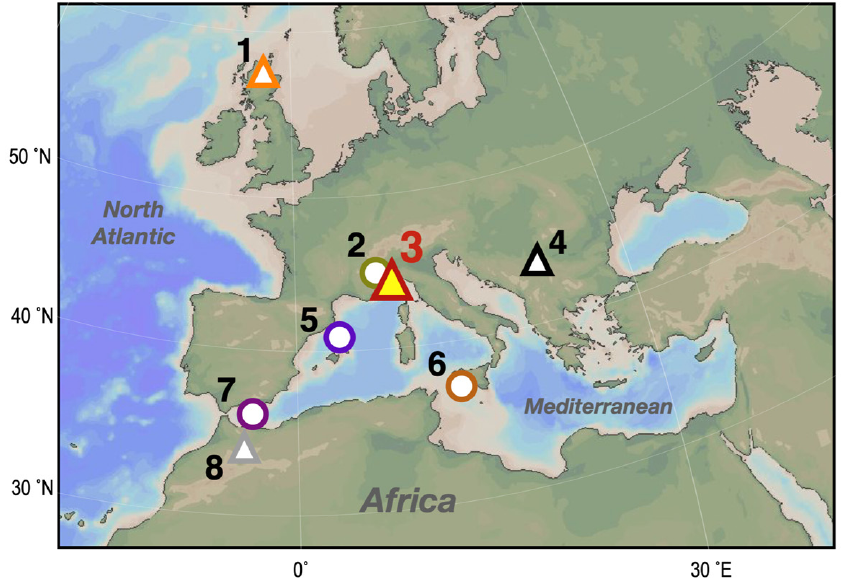
Figure 1. Locations of Bàsura cave and other cited terrestrial and marine sites. Triangles denote caves, and circles denote other terrestrial and marine sedimentary sites: (1) Roaring cave, Scotland [22]; (2) Lake Savine [23]; (3) Bàsura cave, northern Italy (this study); (4) Clo ş ani cave, Romania [24]; (5) Marine sediment core TTR17-434G, Alboran Sea [25]; (6) Marine sediment core SW104-ND11, Sicily Channel [26]; (7) Marine sediment cores MINMC06 and HER-MC-MR3, Minorca Basin [27]; (8) Chaara cave, Morroco [28]. The map was generated using Ocean Data View.